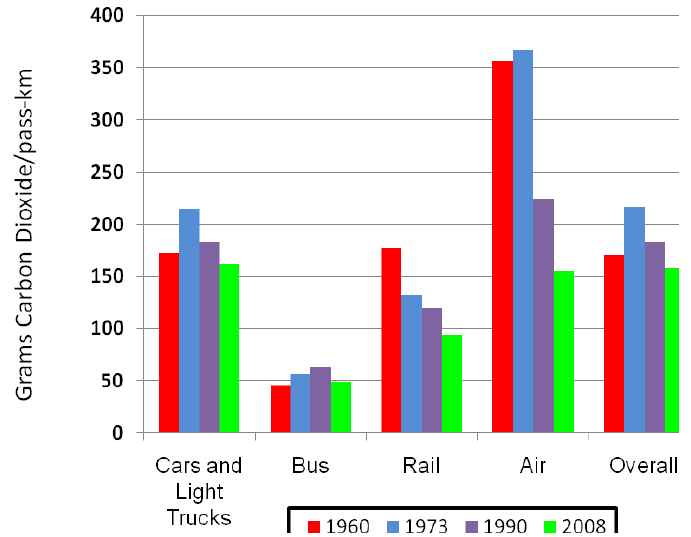
Figure 7. Carbon Intensities of Travel by